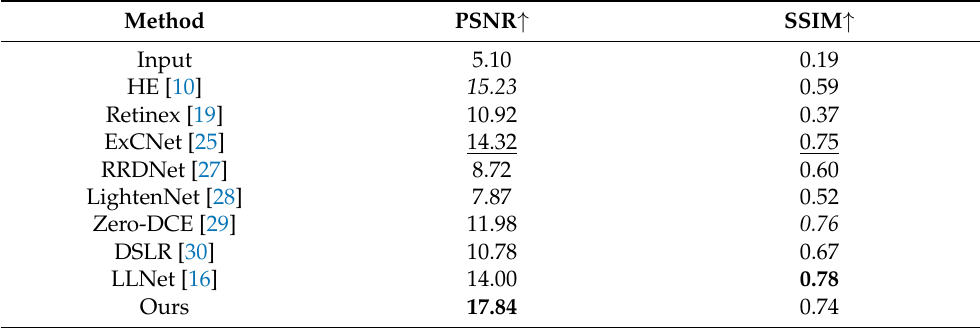
Table 1. The LOL dataset (paired dataset) was quantitatively evaluated according to PSNR and SSIM . The best results are shown in bold, the second is italic, and the third is underlined.